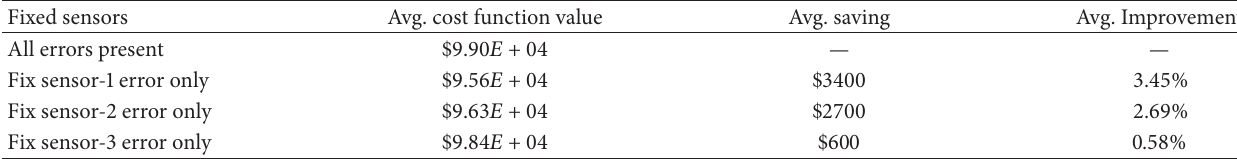
Table 1: Error elimination of sensors with perfect knowledge (KPI-1).